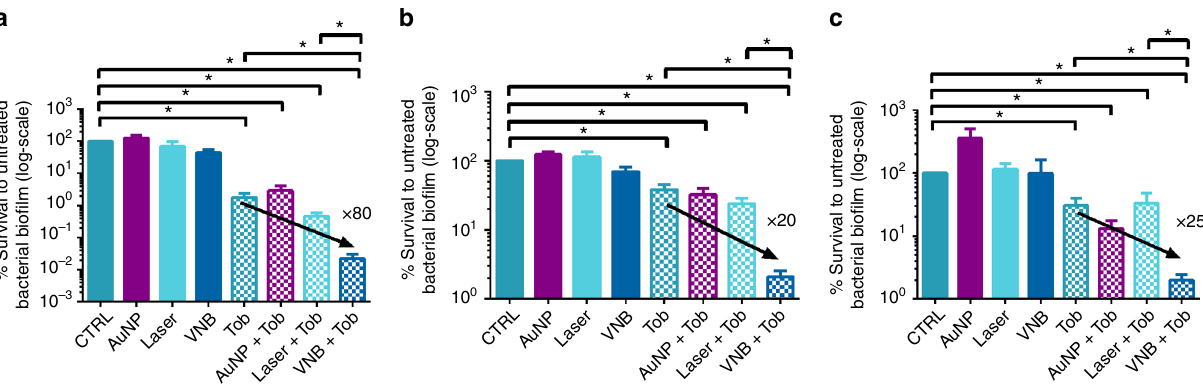
Fig. 5 Anti-bio fi lm effect of combined treatment of 1× VNB formation and tobramycin. Data shown are log of the % survival CFU/bio fi lm compared to the untreated control (average ± SEM) in a B. multivorans , b P. aeruginosa , and c S. aureus bio fi lms. Control: 0.9% NaCl solution, AuNP: only addition of 70 nm spherical gold nanoparticles, Laser: only laser treatment (each location of the bio fi lm received 1 laser pulse), VNB: addition of AuNP with subsequent laser treatment created vapour nanobubbles, Tob: tobramycin treatment for 24 h at 37 °C, AuNP + Tob: addition of AuNP with subsequent tobramycin treatment, Laser + Tob: laser and subsequent tobramycin treatment, VNB + Tob: addition of AuNP with subsequent laser and tobramycin treatment. CTRL contained 9 × 10 6 ± 3 × 10 6 CFU/bio fi lm, 2 × 10 7 ± 1 × 10 7 CFU/bio fi lm, or 2 × 10 6 ± 2 × 10 6 CFU/bio fi lm for B. multivorans , P. aeruginosa , or S. aureus bio fi lms